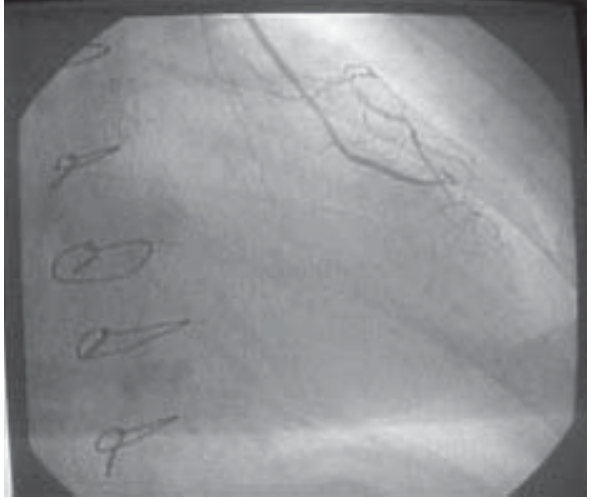
Fig. 2 - Angiographic study of a left internal thoracic artery implanted in the muscle of the left ventricle. Observe the collateral circulation between the left internal thoracic artery, the anterior interventricular and septal arteries.